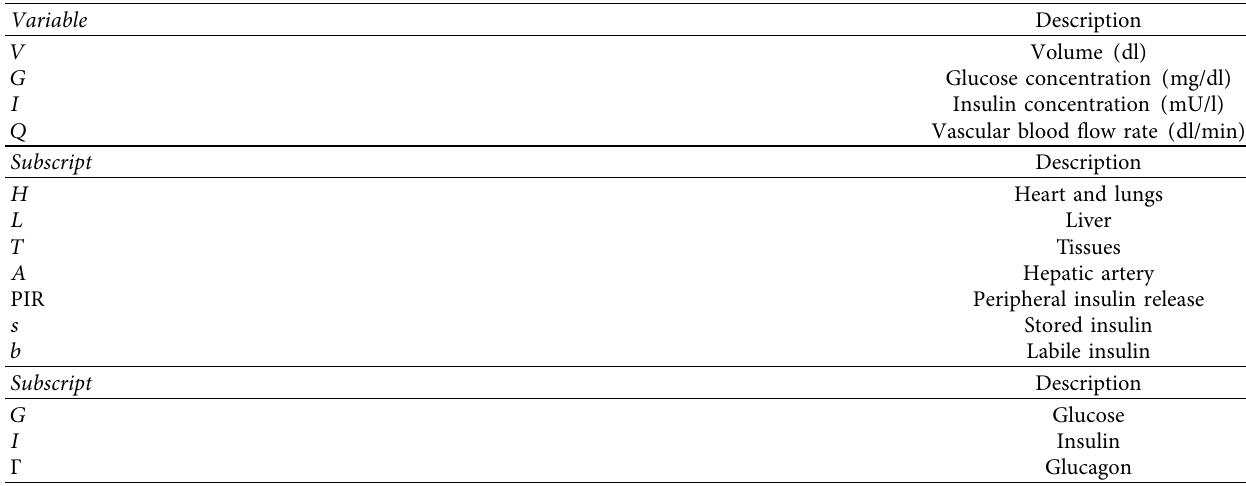
Table 1: Nomenclature of mathematical model.